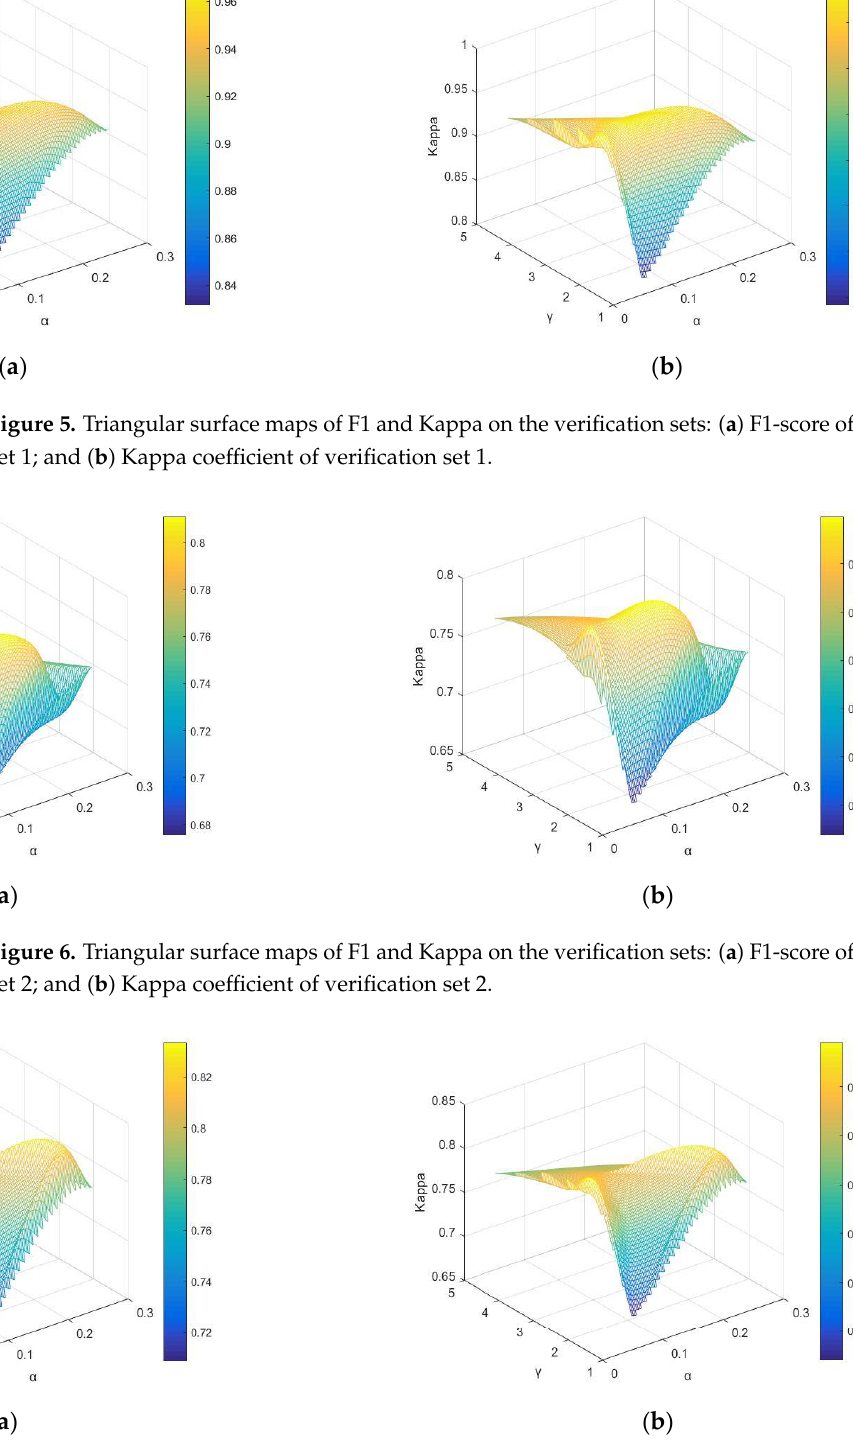
Figure 7. Triangular surface maps of F1 and Kappa on the verification sets: ( a ) F1-score of verification set 3; and ( b ) Kappa coefficient of verification set 3.